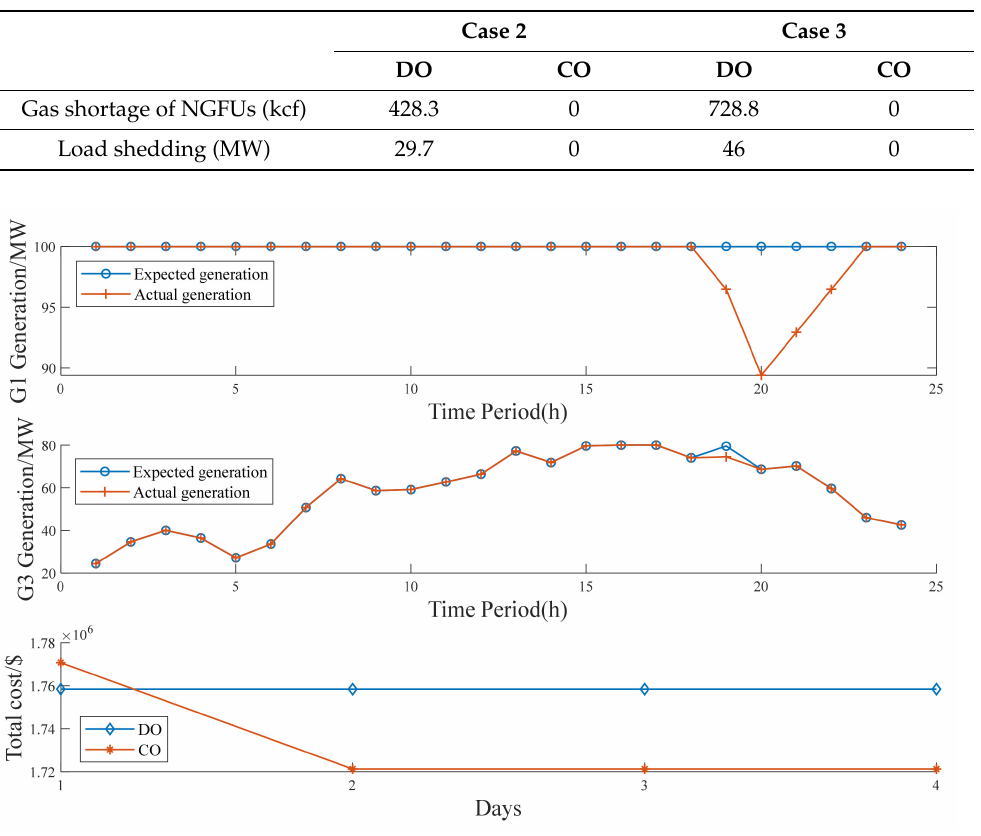
Figure 11. Hourly generation and total cost of